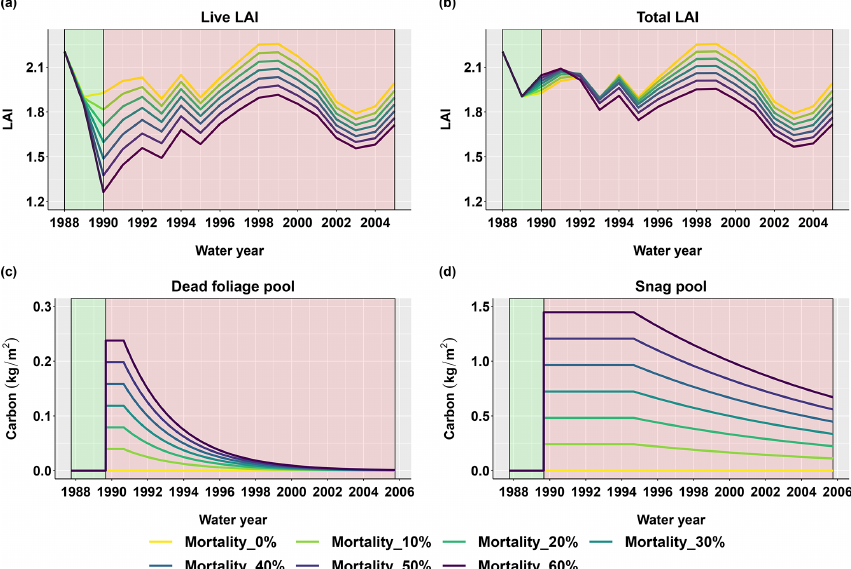
Figure 5. Basin-scale vegetation responses after a beetle outbreak for different evergreen mortality levels. (a) Annual live leaf area index (live LAI), (b) annual total LAI (calculated including the dead foliage pool), (c) daily dead foliage pool, and (d) daily snag pool after the outbreak. The green and red background colors denote the periods before and after the beetle outbreak,